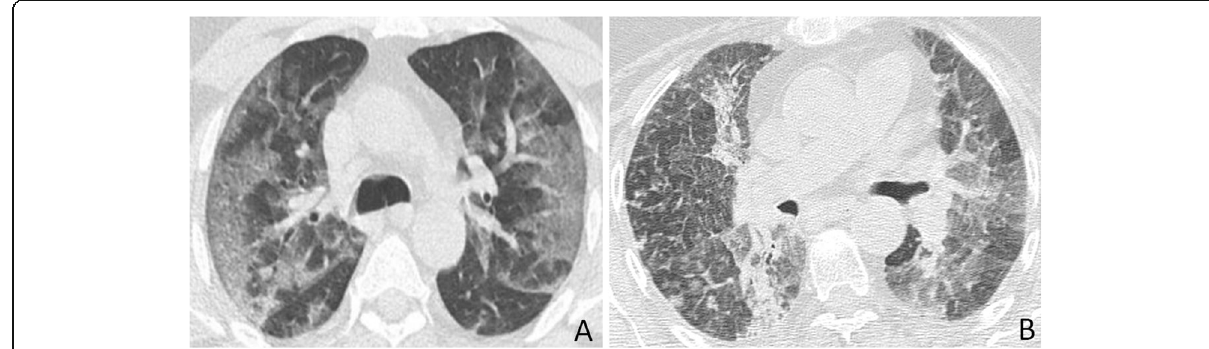
Fig. 5 COVID-19 and drug-induced lung injury misdiagnosed as COVID-19. a Axial CT image obtained from a 62-year-old man with positive PCR test for COVID-19 shows multifocal peripheral GGO with superimposed interlobular septal thickening and visible intralobular lines ( “ crazy-paving ” ).